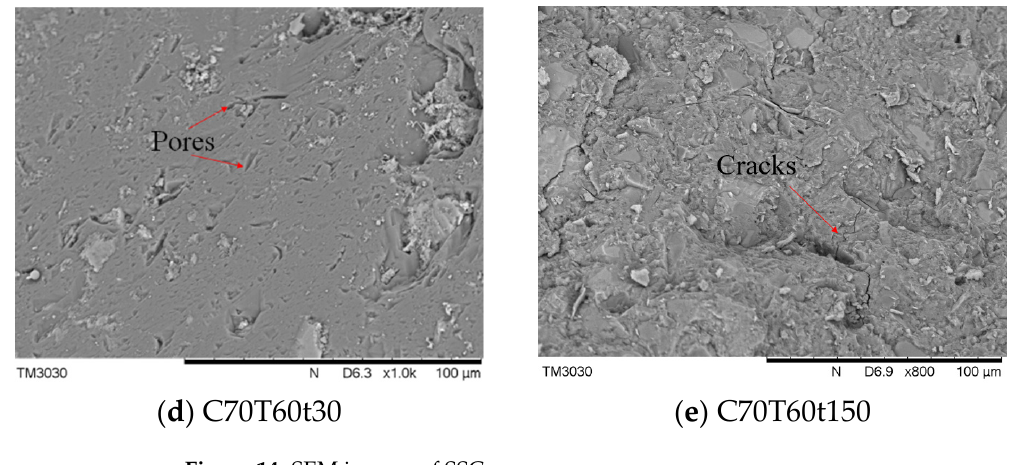
Figure 14. SEM images of SSC.